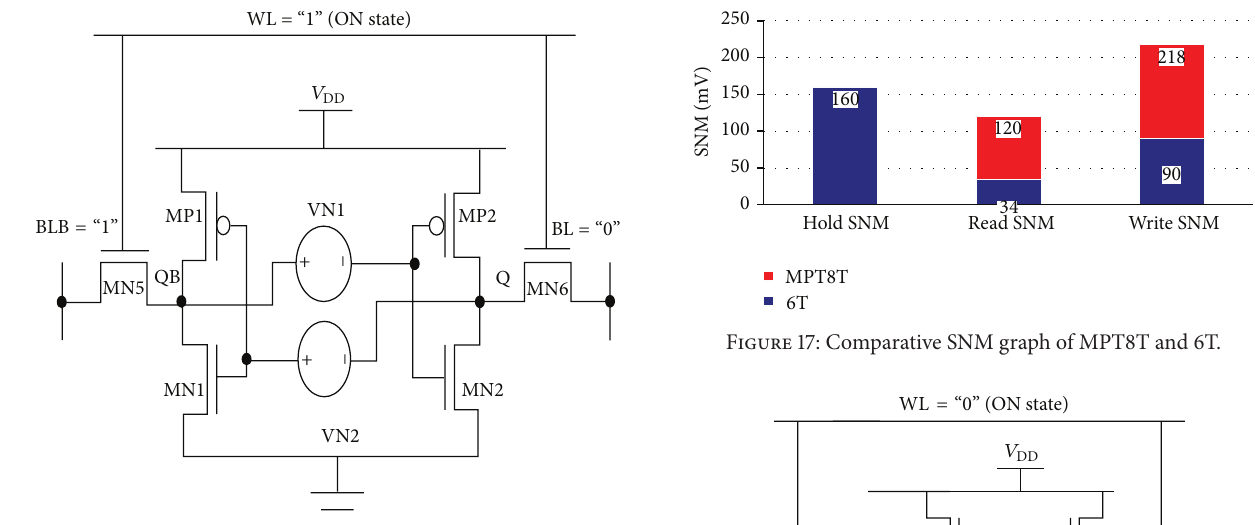
Figure 15: Test circuit for measurement of WSNM of 6T.